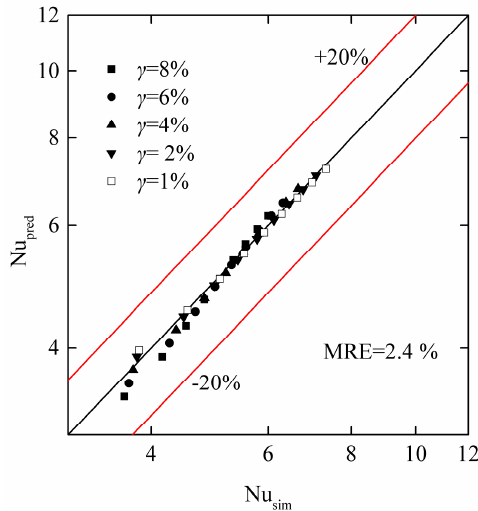
Figure 5. Comparison of the simulated Nu with the predictions of Equation (15) for the NPFA.